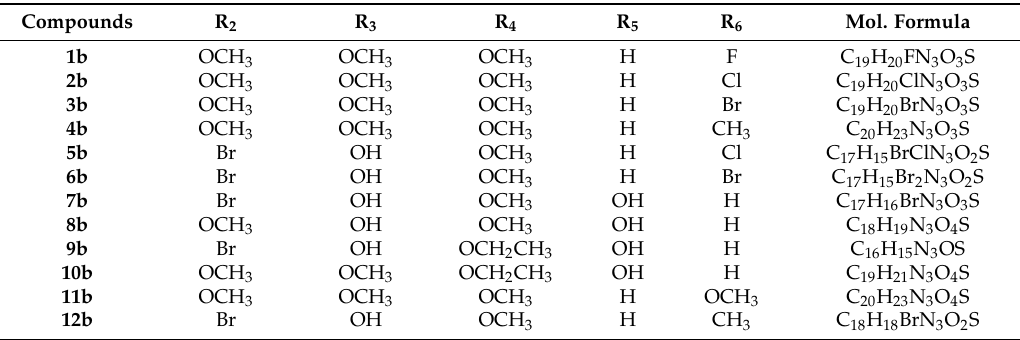
Table 1. Characterization data of compounds 1b – 12b .